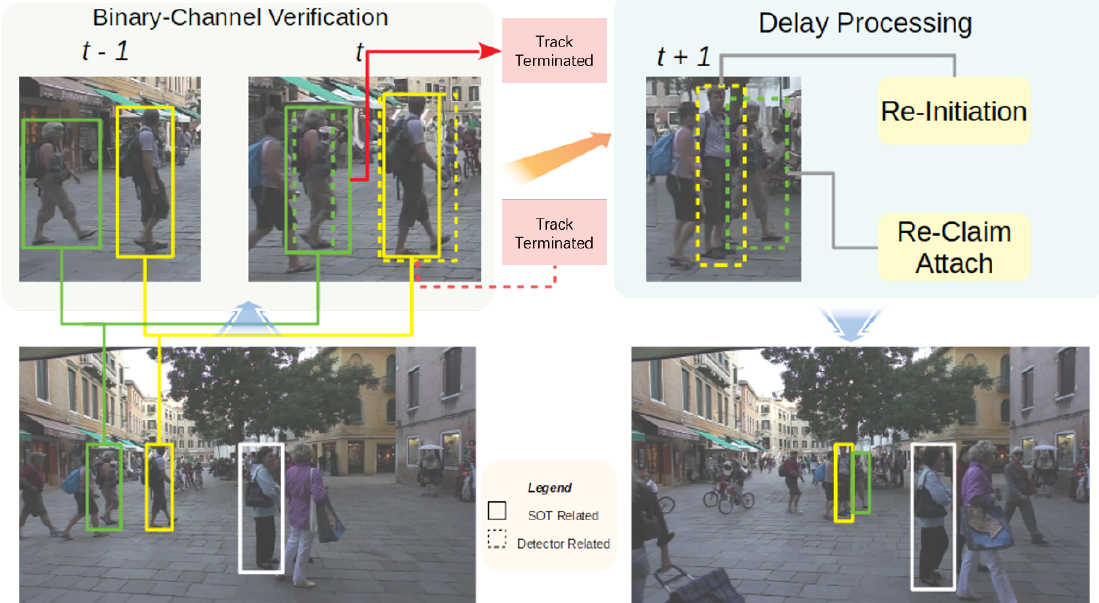
Figure 2. An example of our method. At time t , the estimated bounding boxes provided by every single object tracker are sent to the binary-channel verification model along with the bounding boxes from the external detector, where the determination of the output is based on the evaluation score of the single object tracker alone. Then, a delay processing model focusing on potential complex circumstance like t + 1 above is proposed to handle occlusion, deformation, etc. Single object tracking